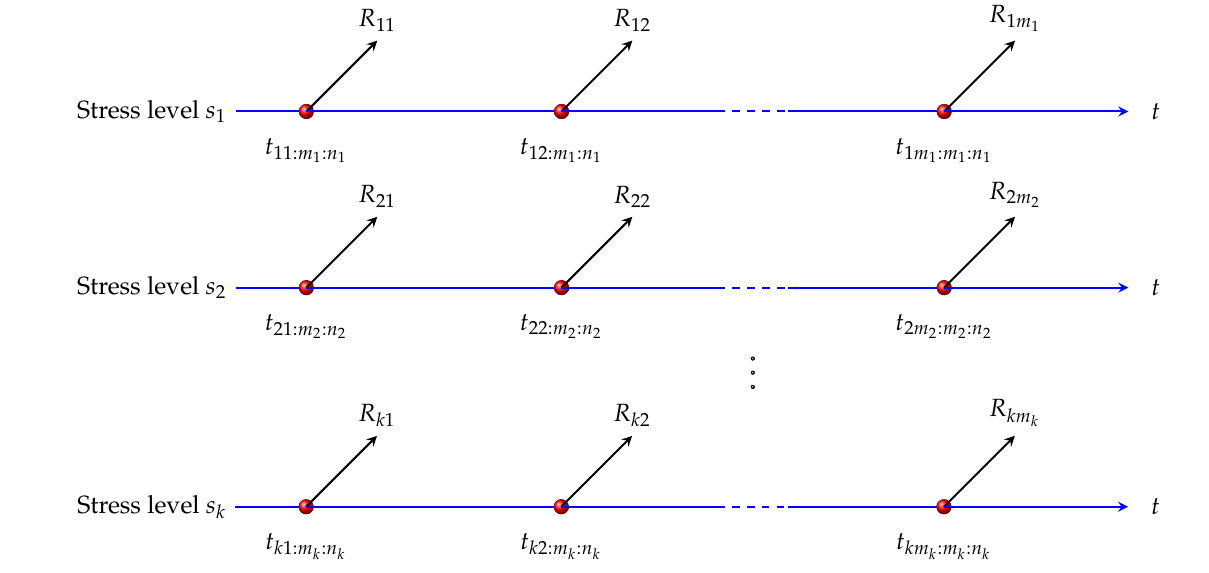
Figure 8. For n i assigned units, progressive Type-II censoring scheme level s i , i = 1,2, . . . k , in constant-stress accelerated life